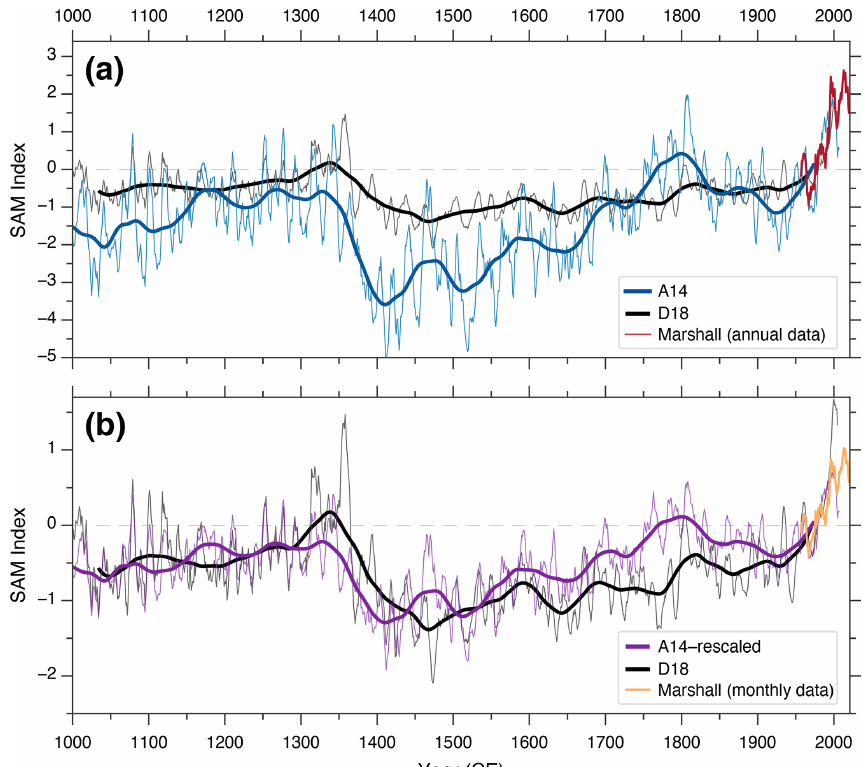
Figure 3. The effect of calibration target on scaling of last millennium SAM reconstructions. (a) Observation-based annual SAM index (Marshall, 2003) calculated using annual MSLP anomalies (red line; shown as 7-year moving average), which forms the calibration target for the A14 SAM reconstruction (blue line; shown as a 7-year moving average and 70-year loess filter by thin and thick lines, respectively). (b) Observation-based annual SAM index (Marshall, 2003) calculated using monthly MSLP anomalies (orange line; shown as 7-year moving average) and the result that this alternate calibration target has on the scaling of A14 SAM reconstruction (purple line; shown as a 7-year moving average and 70-year loess filter by thin and thick lines, respectively). For comparison, the D18 SAM reconstruction is shown in black (7-year moving average and 70-year loess filter by thin and thick lines, respectively) in both panels (a) and (b) and is based on a monthly derived annual SAM index as the calibration